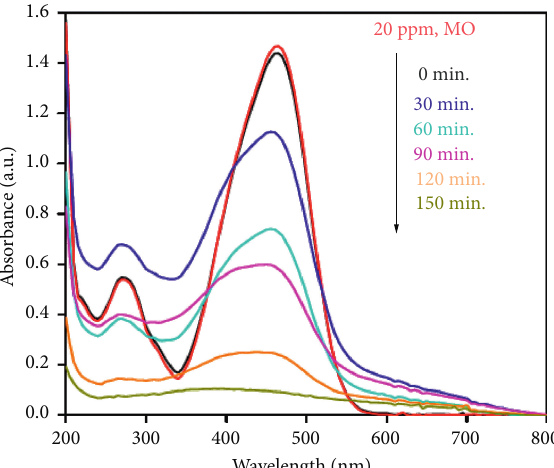
Figure 12: Degradation of MO using PVP-biogenic-assisted synthesized TiO